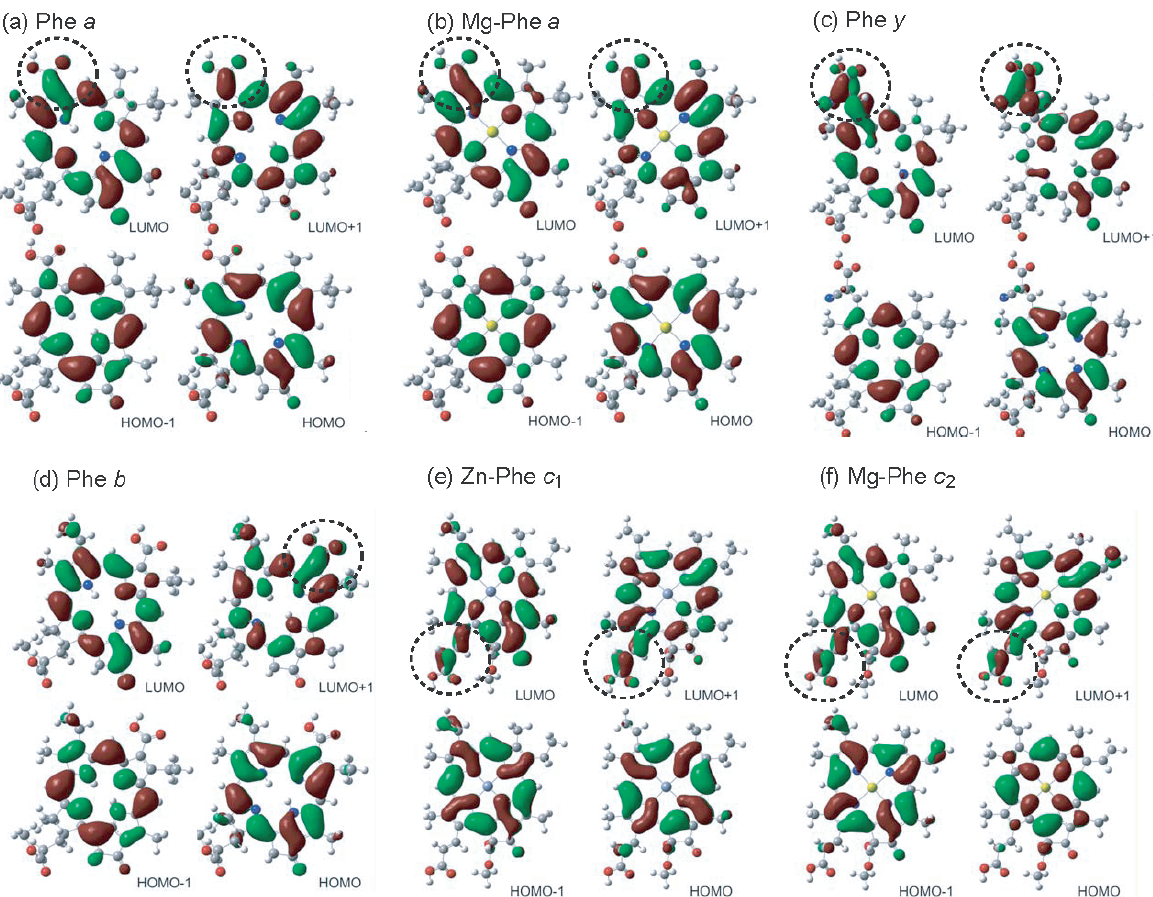
Figure 26. The four orbitals including HOMO–1, HOMO, LUMO and LUMO+1 obtained by TD-DFT calculations (reproduced from [7] with permission of MDPI